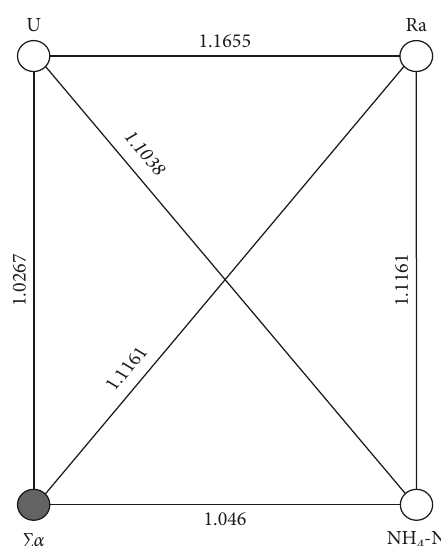
Figure 3: The relation graph of the shortest distance ( G